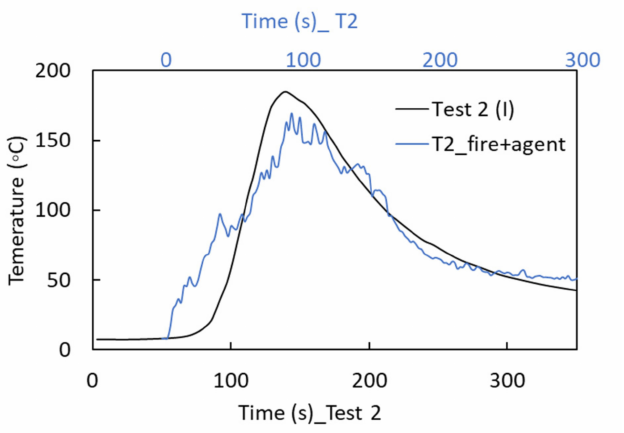
Figure 8. Temperature at location P3.